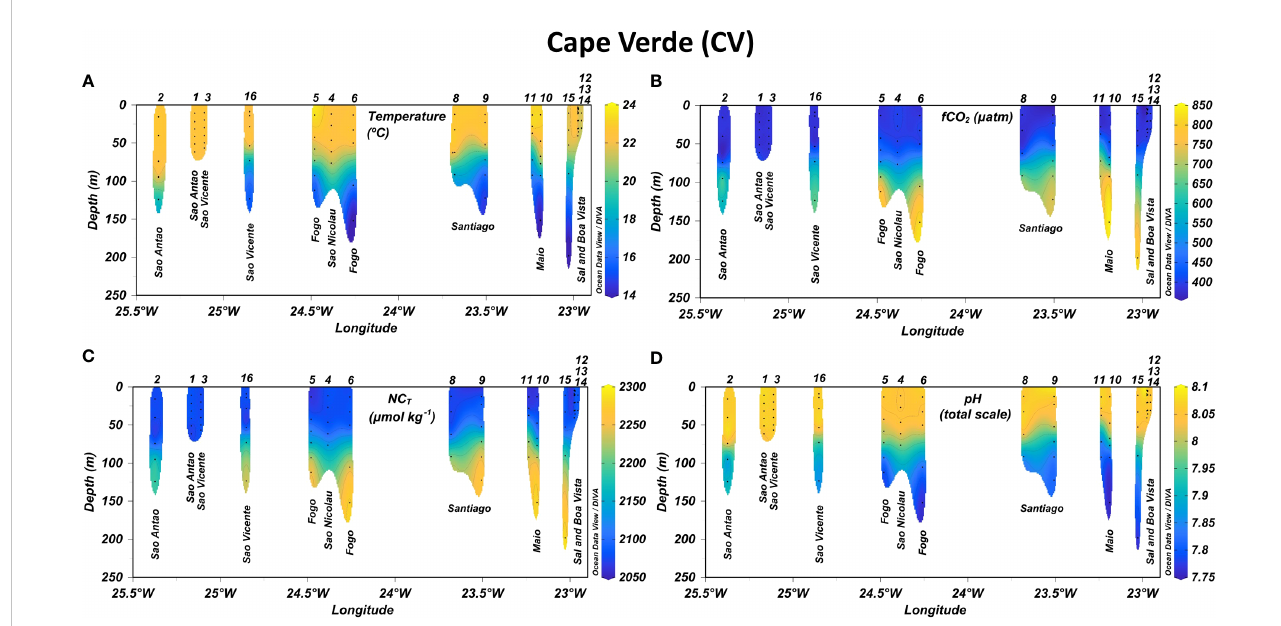
FIGURE 2 Longitudinal distribution of (A) temperature, (B) CO 2 fugacity in seawater ( f CO 2,sw ), (C) normalized total inorganic carbon (NC T ) and (D) pH in the fi rst 250 m depth leeward of Cape Verde archipelago. Isolines were added in plots every 1°C for temperature, 50 µatm for f CO 2,sw , 25 µmol kg -1 for NC T and 0.05 units for